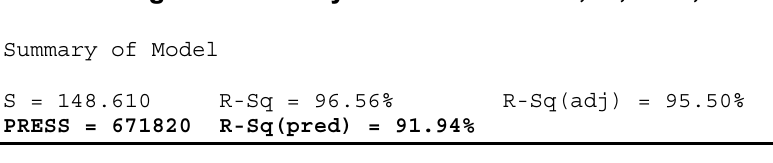
Figure 8. Subsets Regression Four Predictors Subset.